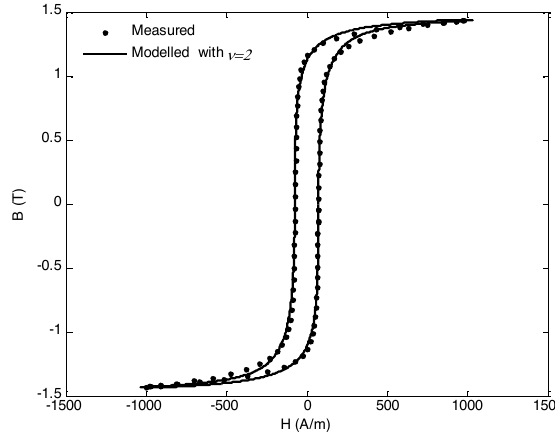
FIGURE 2. Modelled and measured hysteresis loops at 50 Hz